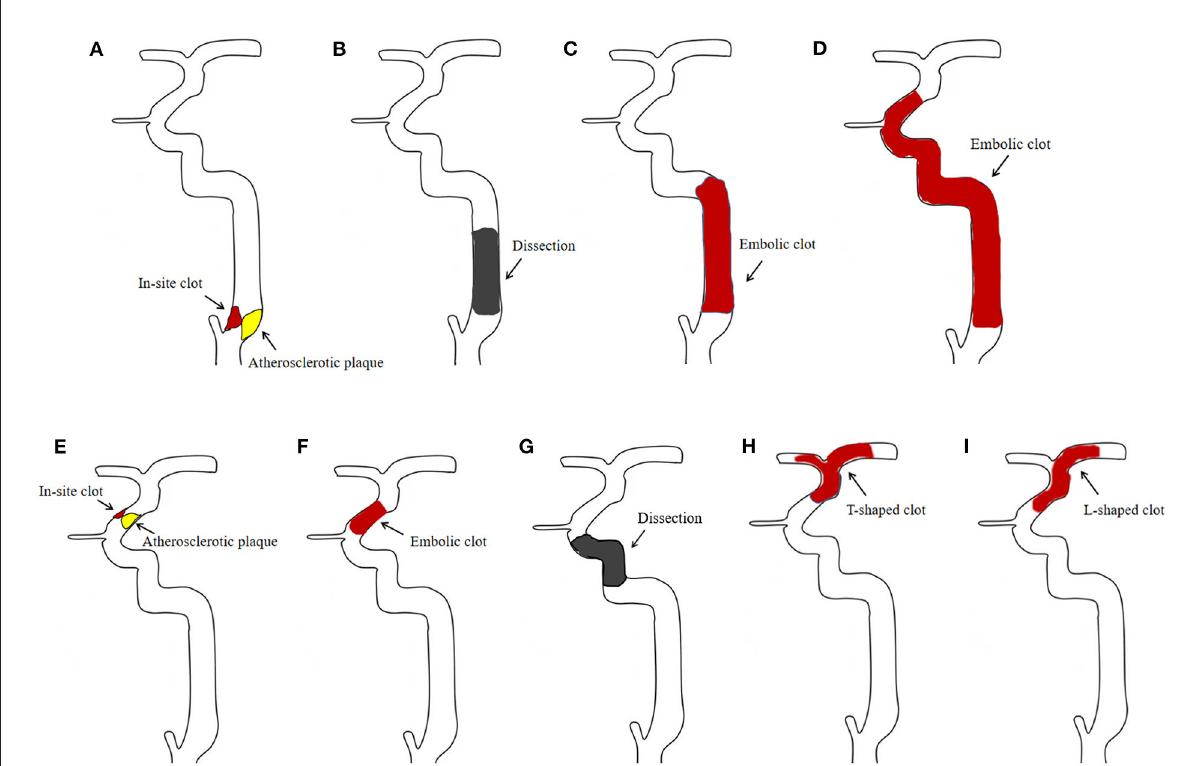
FIGURE2 Schematic diagram of internal carotid artery (ICA) occlusions. True occlusion of the cervical ICA is caused by atherosclerosis (A) , dissection (B) , and massive thrombosis (C, D) . Pseudo-occlusion of the cervical ICA is caused by distal intracranial occlusion (E–I) with the above-mentioned